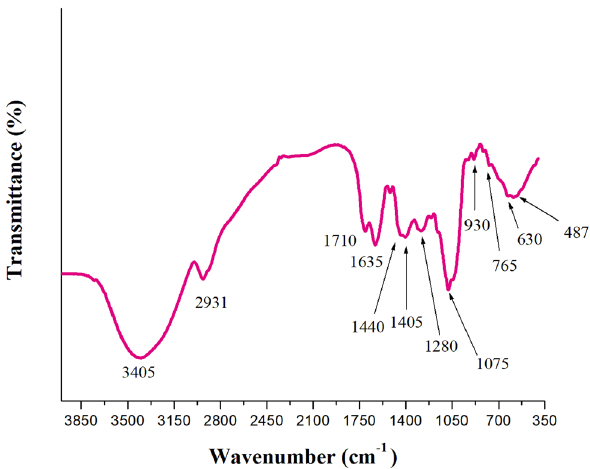
Figure 2: FTIR spectra of: ( a ) Fe 3 O 4 , ( b ) ZnO, ( c ) Fe – ZnO - 1, ( d ) Fe – ZnO - 2, ( e ) Fe – ZnO - 3, ( f ) Fe – ZnO - 4, ( g ) Fe – ZnO - 5, and ( h ) Fe – ZnO -